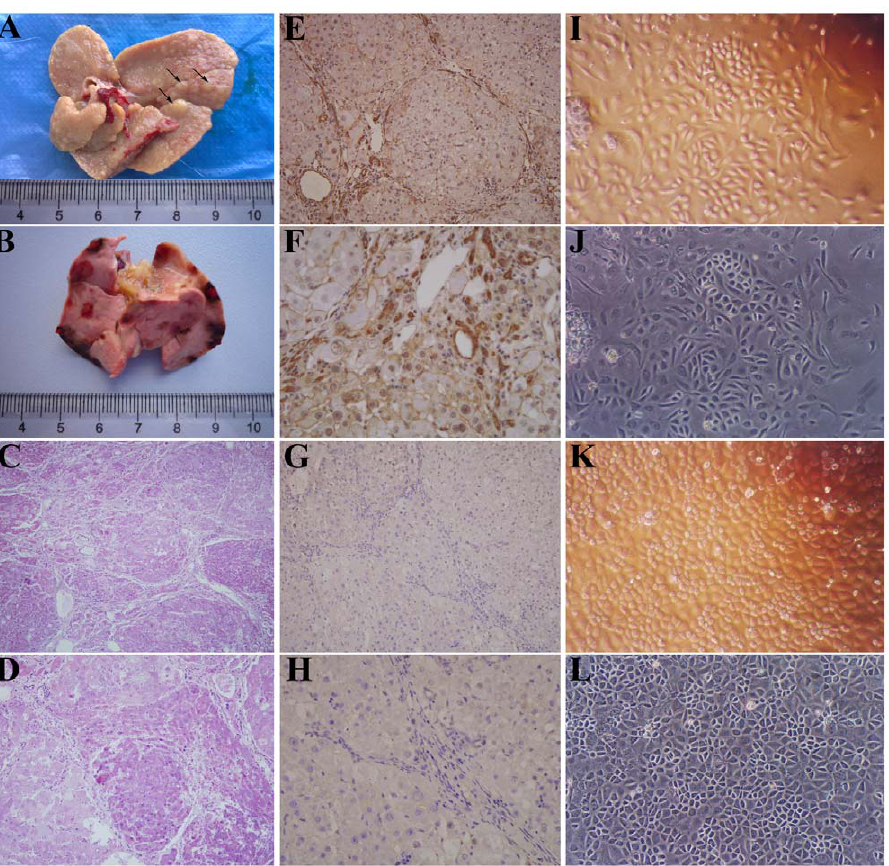
Figure 1. Formation of HCC and isolation of HTCs. (A) Small tumors (black arrows) were caused by 10 weeks of DEN induction. (B) The liver had been almost completely replaced by large tumors 18 weeks after DEN induction. (C) Low magnification view of an H&E-stained section from tumor tissue. (D) High magnification view of an H&E-stained section. (E) Low magnification view of an AFP-stained section. (F) High magnification view of an AFP-stained section. (G) Low magnification view of a CK-19-stained section. (H) High magnification view of a CK-19-stained section. (I, J) Images of primary cultured HTCs. (K, L) Images of HTCs purified by DTDA. Original magnifications: 100 6 (C, I–L), 200 6 (D, E, G), 400 6 (F, H).